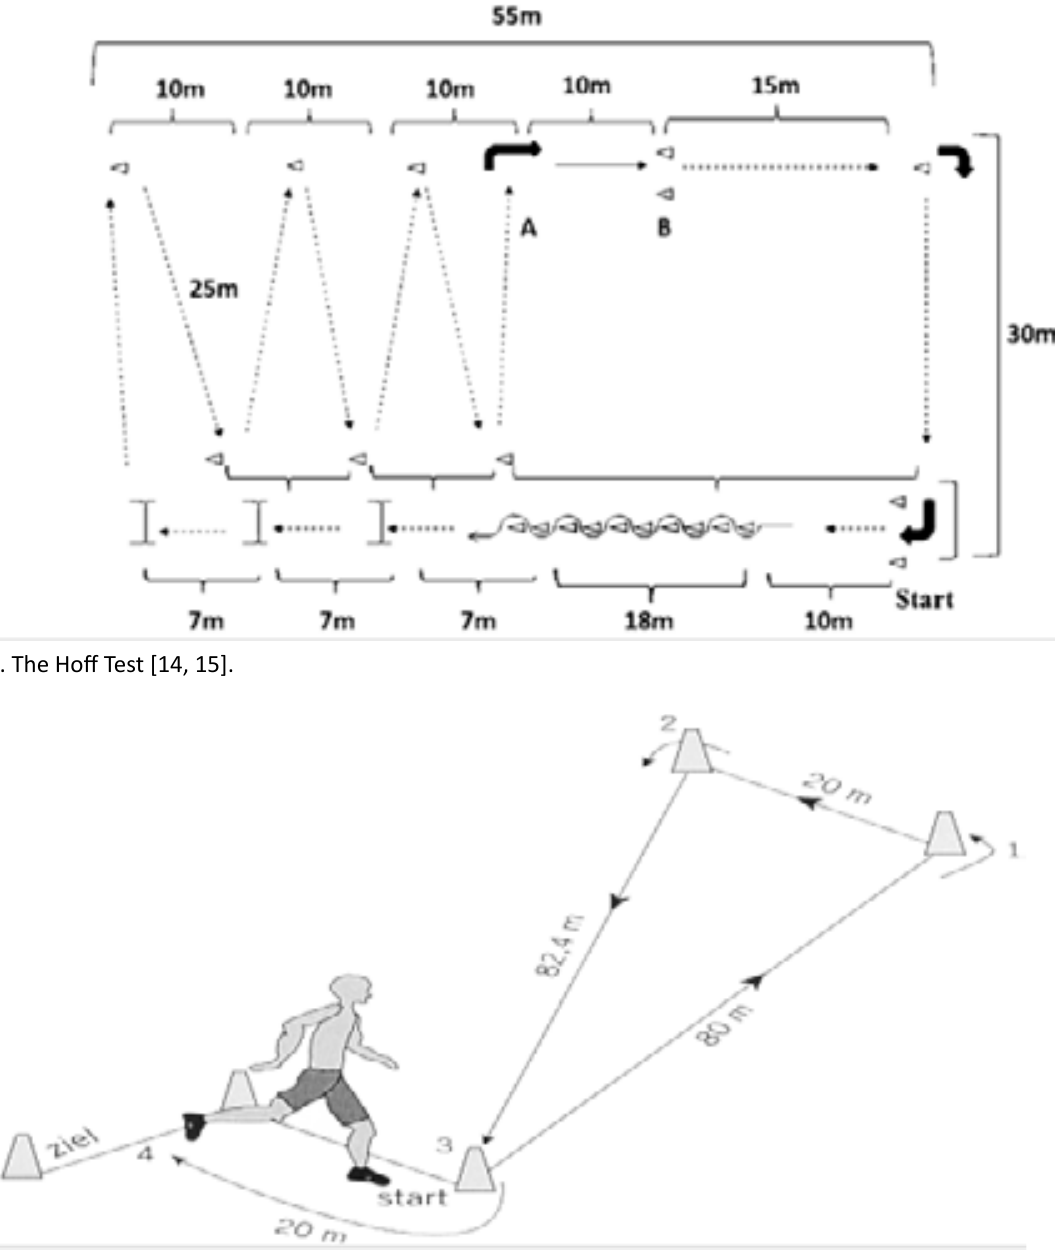
Figure 2. T-Test